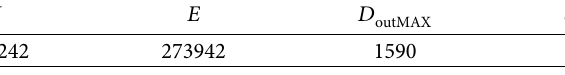
Table 2: Parameters of experimental datasets.